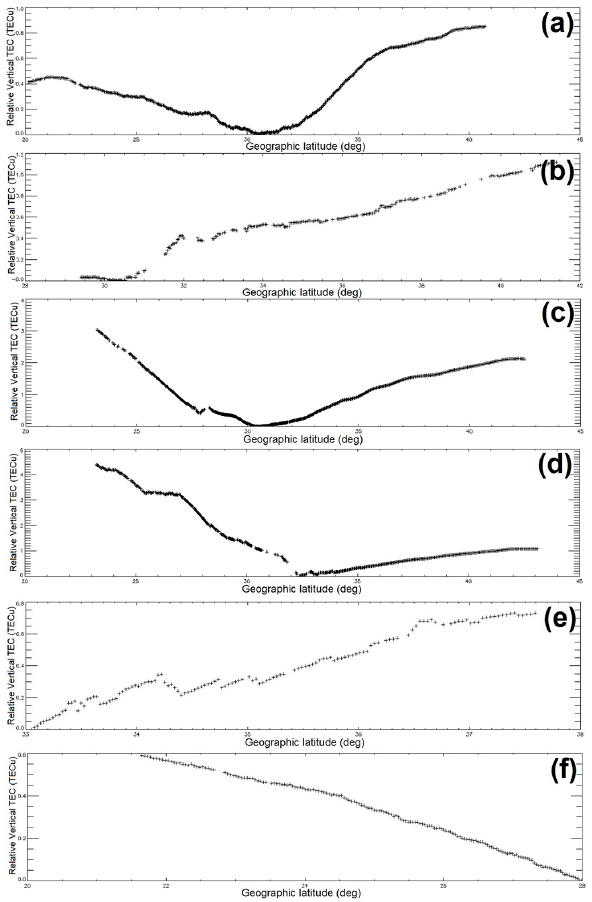
Figure 3. VTEC versus geographic latitude of the F region inter- cept. The passage time corresponds to the same panels (alphabeti- cally sequenced) in Fig.